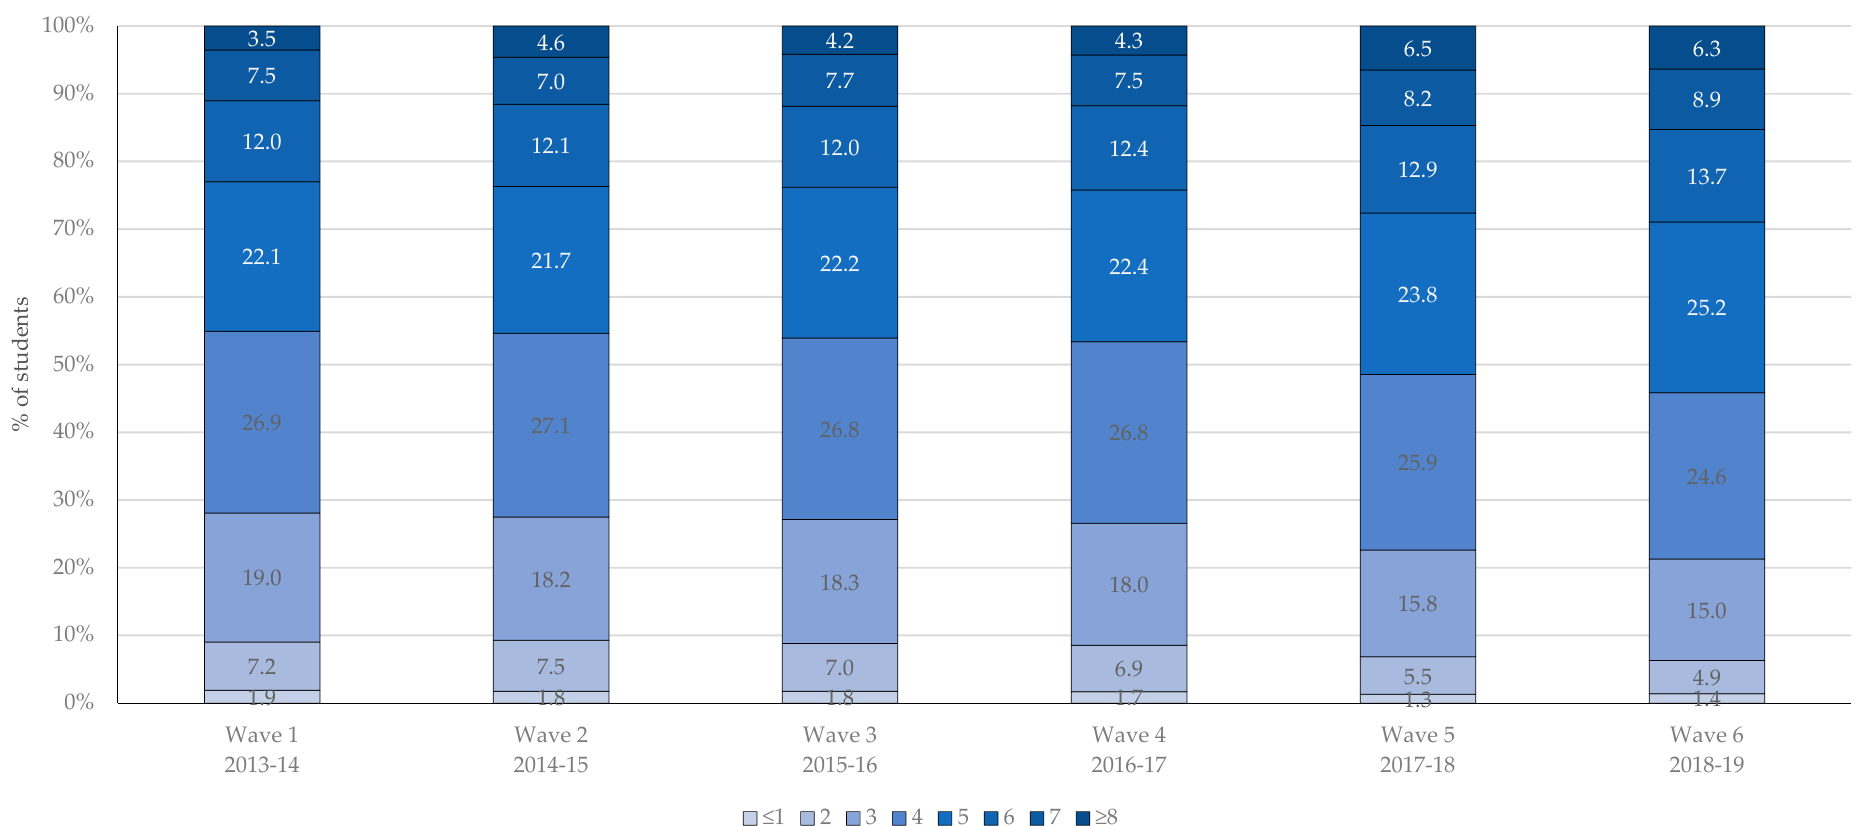
Figure 2. Prevalence of co-occurring health risk behaviours among grade 12 students (n = 44,740) by wave, 2013-19 COMPASS study.